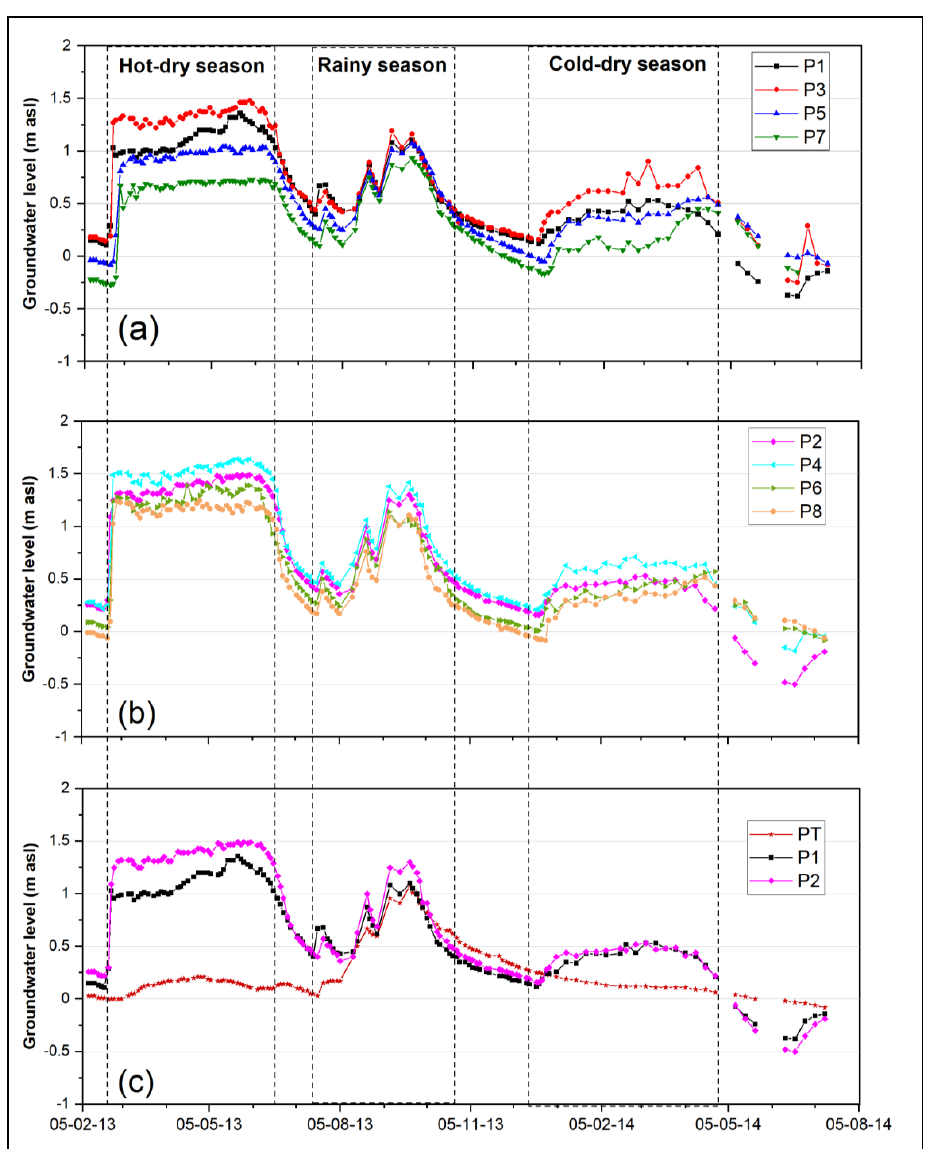
Figure 3. Fluctuation of the groundwater level in the piezometers located along the irrigation channel ( a ), along the drainage channel ( b ) and in a control piezometer located 2000 m outside the irrigated plot ( c ).